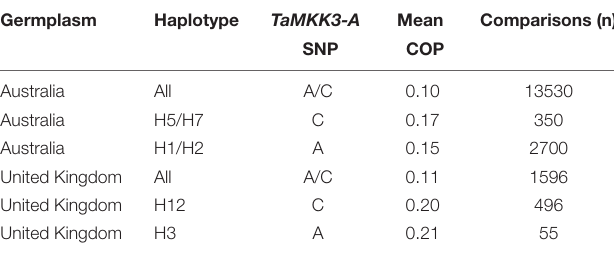
TABLE 2 | Mean Coefficient of Parentage (COP) within Australian and United Kingdom germplasm, and between groups of the most prevalent haplotypes containing dormant (C) and non-dormant (A) SNPs at TaMKK3-A . Germplasm Haplotype TaMKK3-A